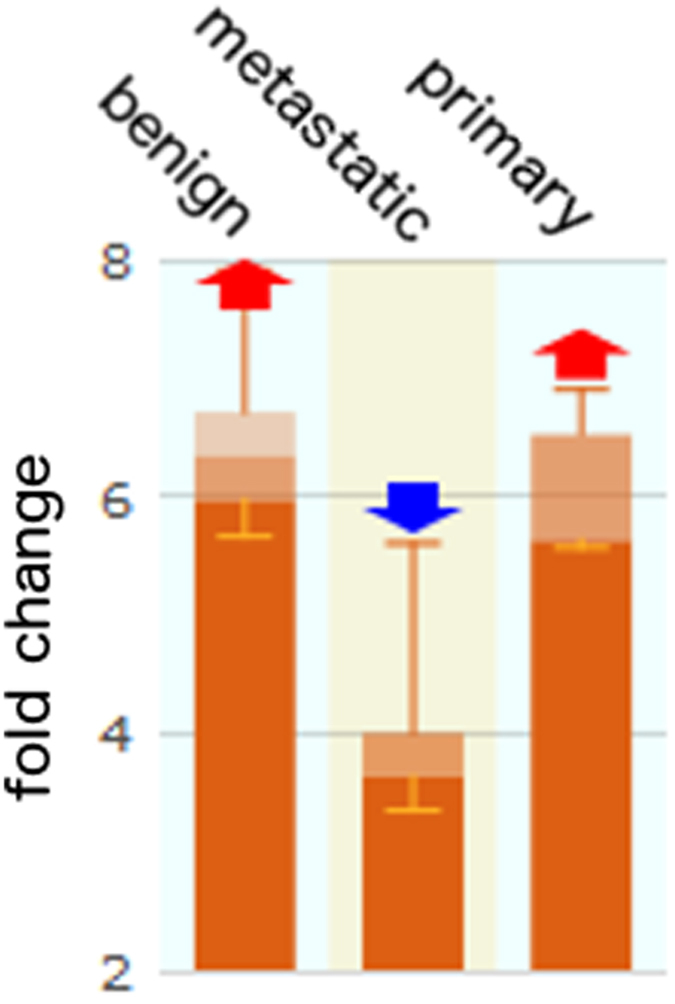
IL-33 expression is reduced in human metastatic prostate cancer.IL-33 gene is down-regulated in human metastatic prostate cancer compared to human benign and primary prostate tumors. The data was obtained from the Gene Expression Atlas created by the European Biostatistics Institute (Gene Expression Atlas; https://www.ebi.ac.uk/gxa/home; access date: 30/01/2013). A high-throughput immunoblot approach was utilized to characterize proteomic alterations in human prostate cancer progression, focusing on the transition from clinically localized prostate cancer to metastatic disease. They examined protein expression levels and gene transcript levels and found that the proteins that were in agreement with gene expression could be used as a predictor of clinical outcome.